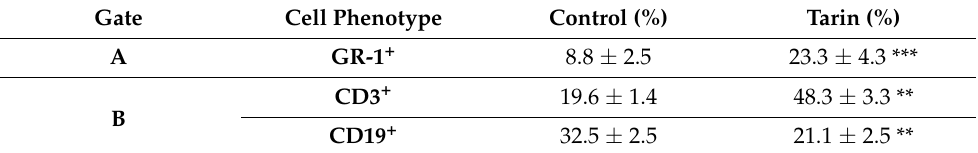
Values indicate the percentage of Gr-1 + , CD3 + , and CD19 + bone marrow cells in gates A or B after 5 days of